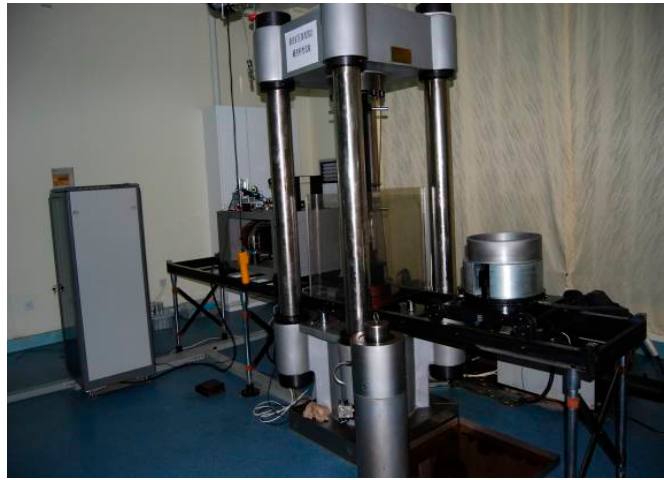
Figure 2. RLJW-2000-type test system.